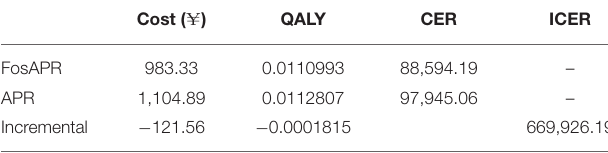
TABLE 9 | Base-case results of FosAPR and APR in